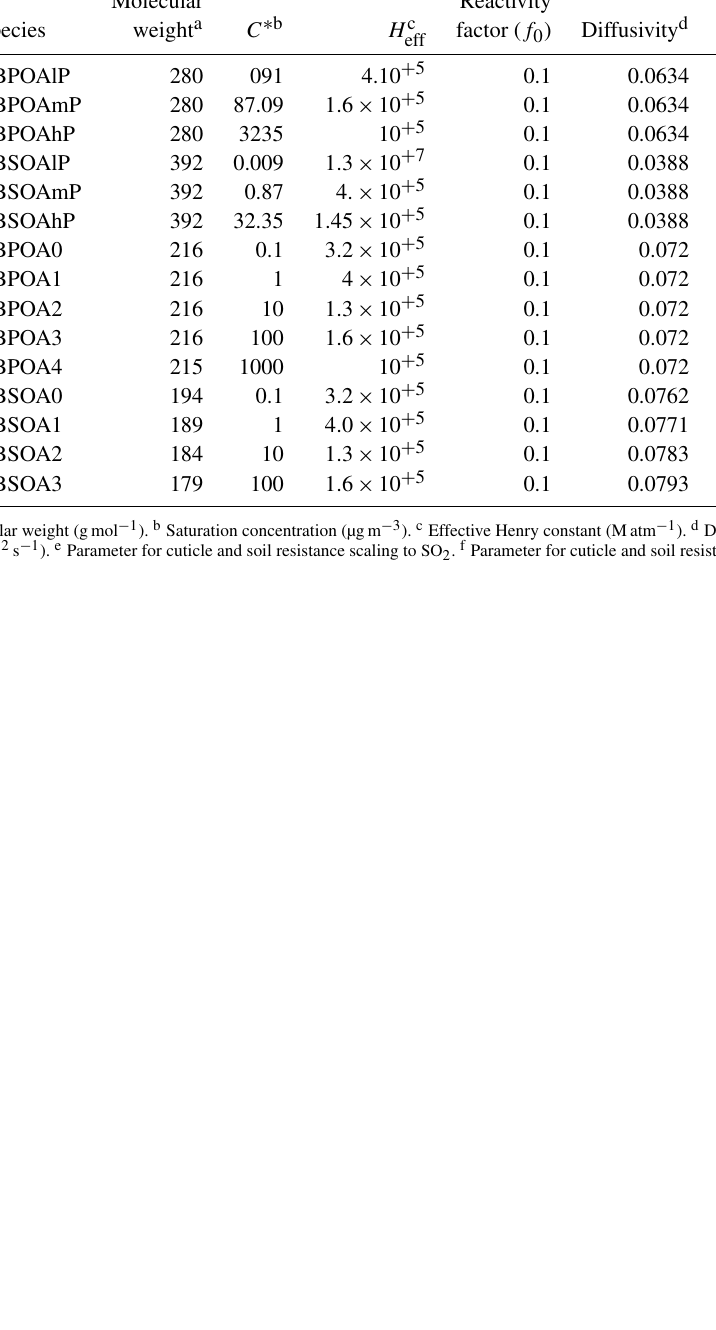
Table E1. Summary of the parameters used to compute the dry-deposition velocities of the gaseous I/S/L-VOCs. Molecular Reactivity Species weight